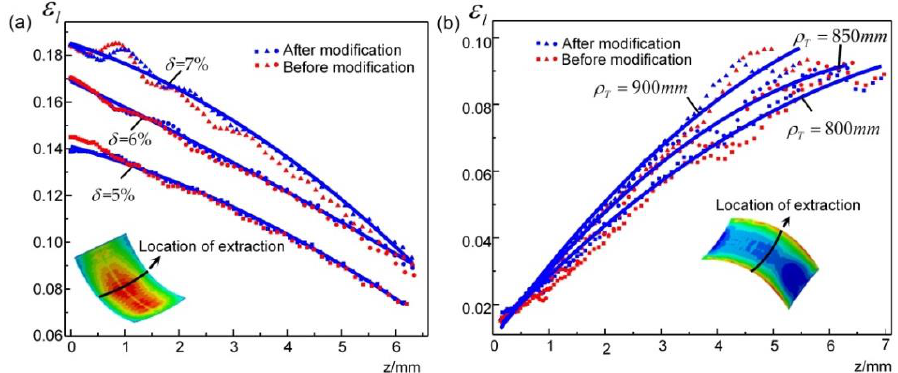
11 of 17 Figure 8. Error nephograms under different compression ratios (  ) of convex surfaces: ( a ) Before modification; ( b ) After modification. The simulated convex surfaces deviate from the target to a large extent before modification, and the modified formula makes the shape and size of the formed surfaces more consistent with the